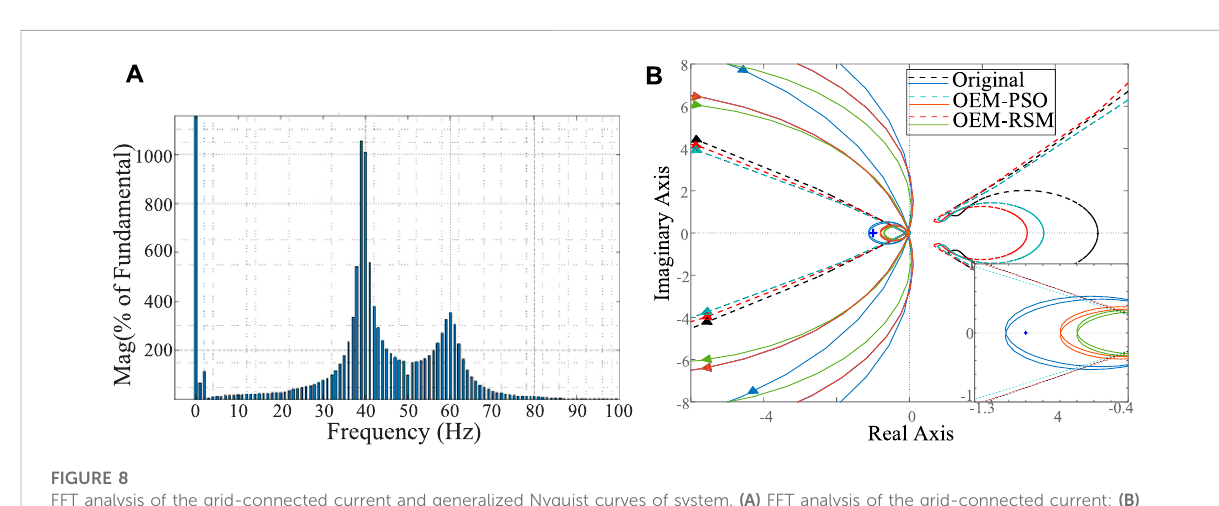
FIGURE 8 FFT analysis of the grid-connected current and generalized Nyquist curves of system. (A) FFT analysis of the grid-connected current; (B) Generalized Nyquist curves.